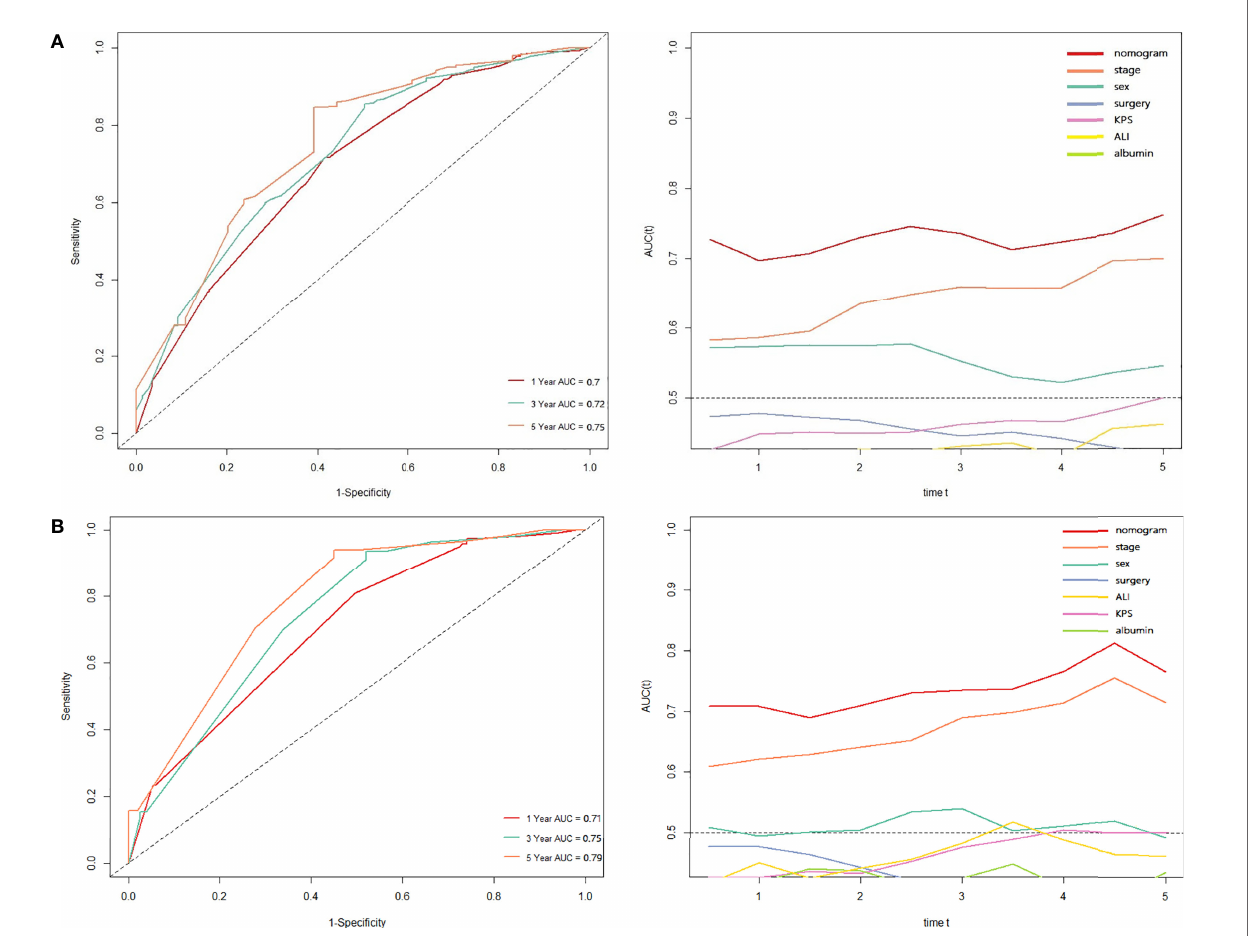
FIGURE 6 | The time ROC curve of the prognostic nomogram in training (A) and validation sets (B)